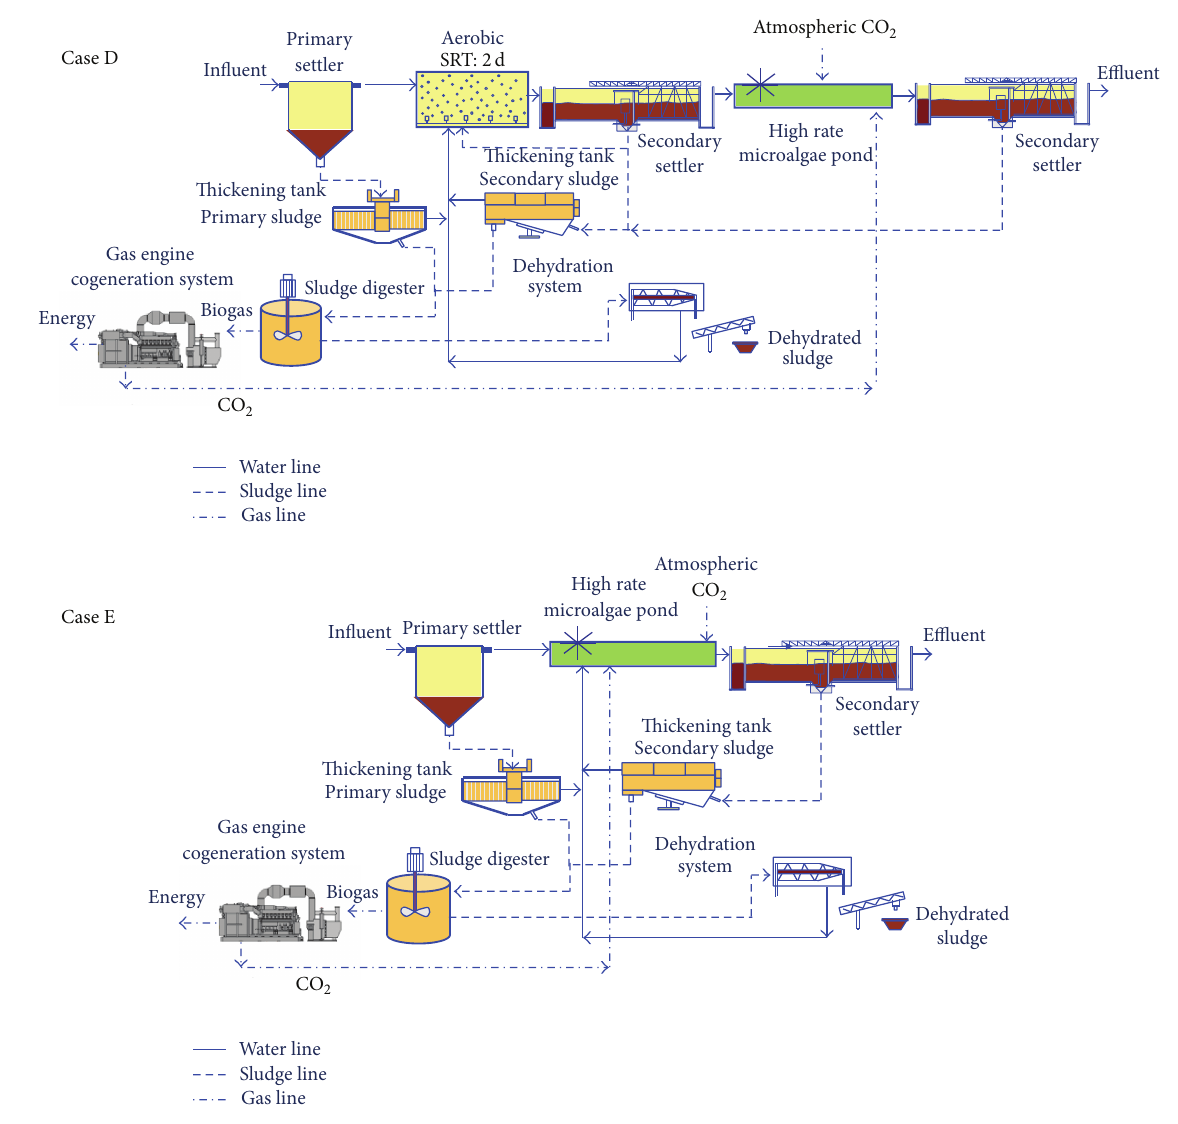
Figure 4: Layout of the five WWTPs configurations evaluated in terms of GHG emissions.